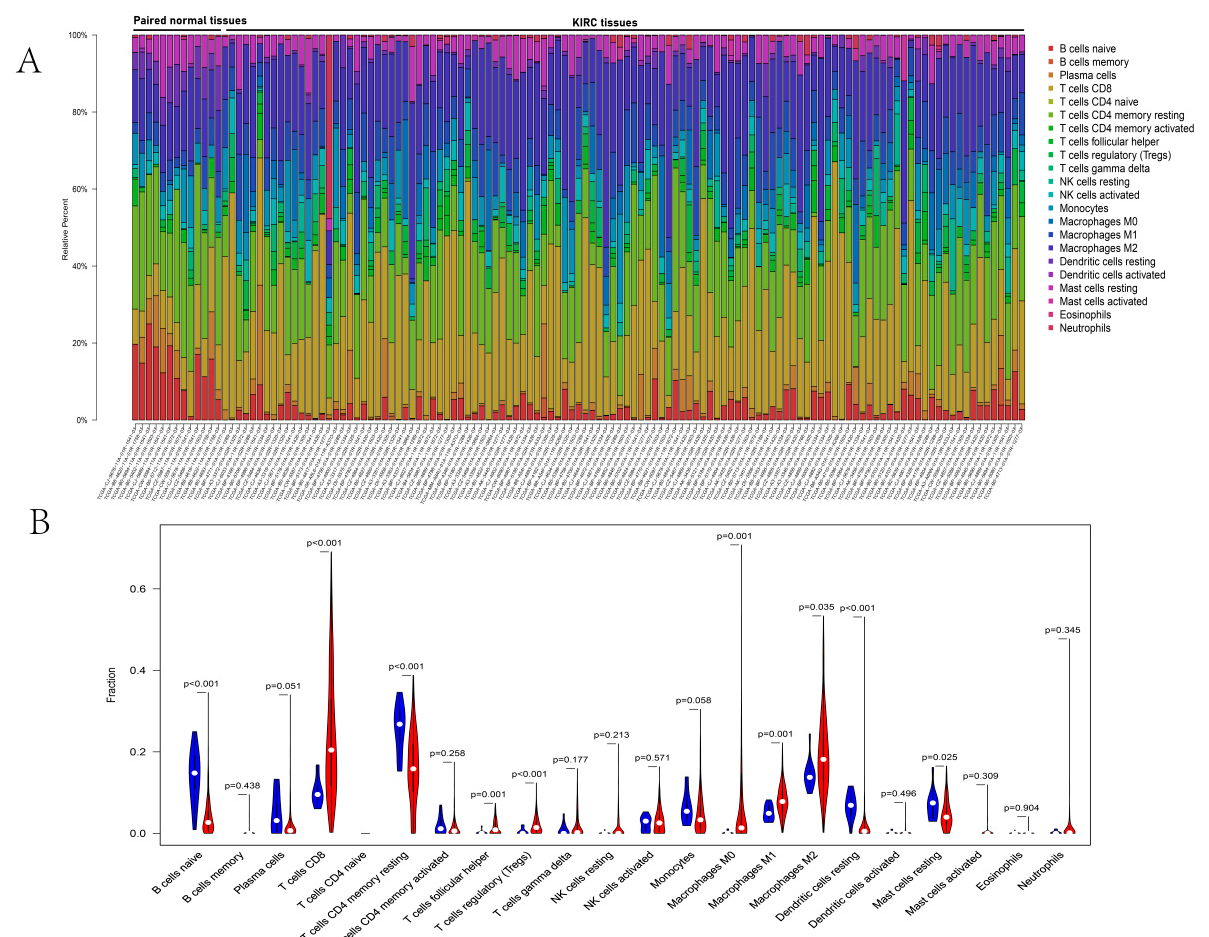
Figure 7. Immune infiltration analyses of DERGs. ( A ) The landscape of immune infiltration between KIRC tissues and paired normal tissues; ( B ) violin plot visualizing differentially infiltrated immune cells. The blue color and red colors represent paired normal tissue and tumor tissue, re- spectively.